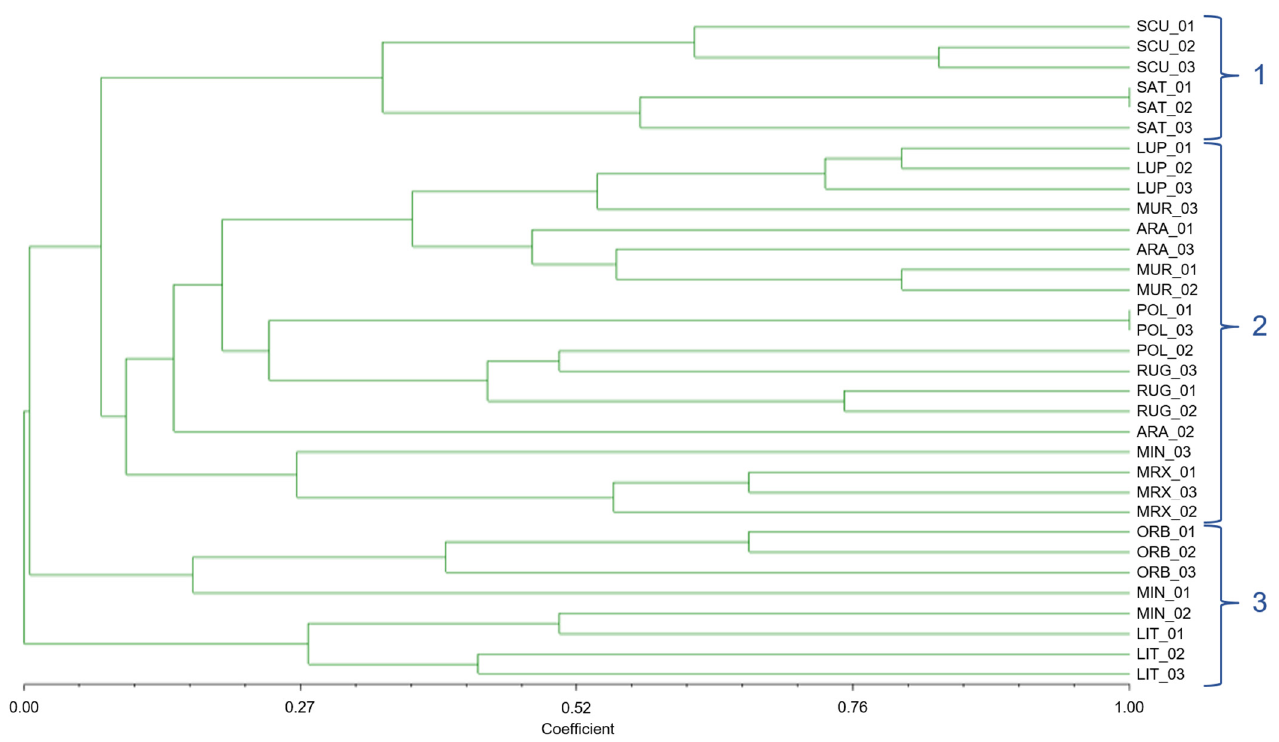
Figure 4. Dendrogram based on Jaccard similarity indices, computed on the basis of UPGMA clustering method, of the 33 individuals of 11 Medicago species, belonging to 3 different sections, with n-SSR alleles.